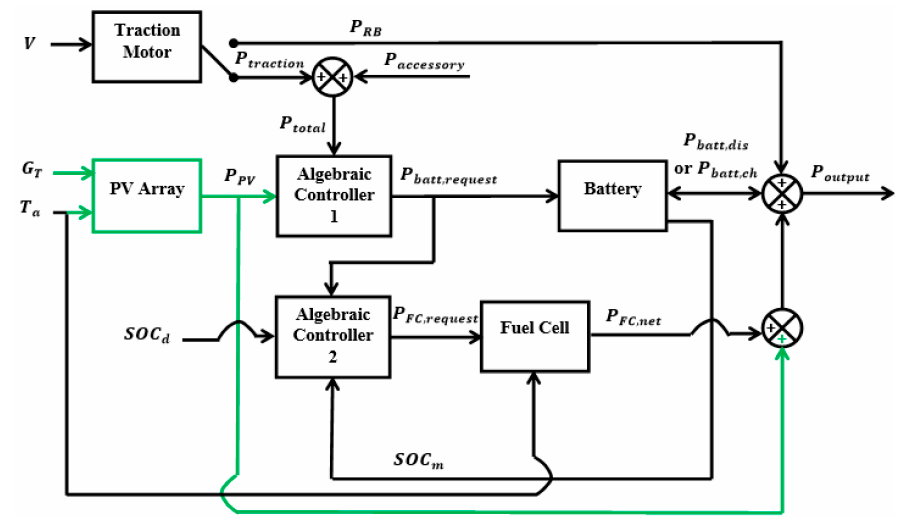
Figure 3. Control block diagram of the PV/fuel cell/battery HRES under the “algebraic control” strategy. Black blocks and lines indicate components of the original control scheme [5]; green blocks and lines indicate modifications to the original control scheme introduced to accommodate the added PV